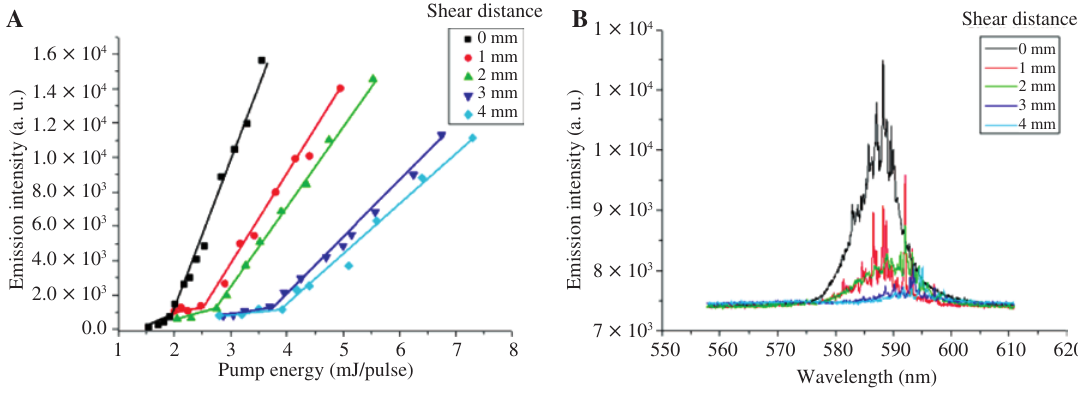
Figure 3: Emission spectra with different shear distances. (A) The dependence of emission integrated intensity on pump energy for the DDPDLCs with different shear distance. (B) Evolution of emis- sion spectra as a function of shear